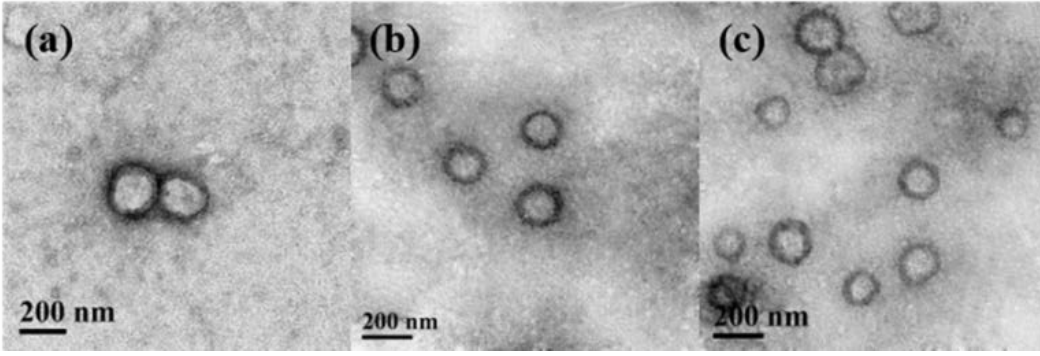
Figure 2. Transmission Electron Microscopy (TEM) images of ( a ) PCL 16 - b -K 11 , ( b ) PCL 16 - b -K 20 , ( c ) PCL 16 - b -K 27 diblock copolymer vesicles .